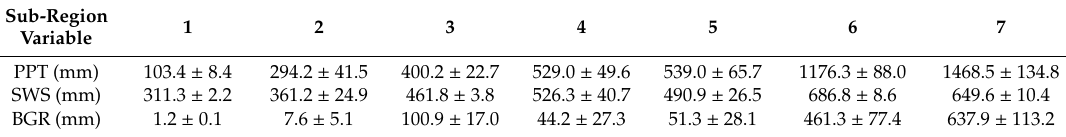
Table 3. Annual average values of PPT, SWS, and BGR in seven sub-regions of